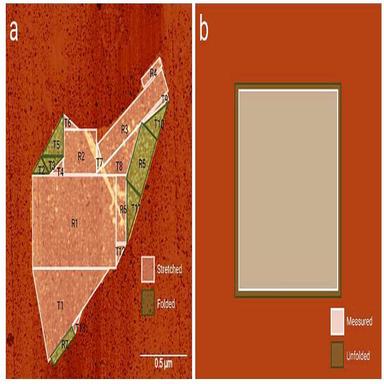
(a) Representation of the developed method for measuring nanosheet area. (b) Comparison of two squares with areas equivalent to the measured and actual areas of the nanosheet.